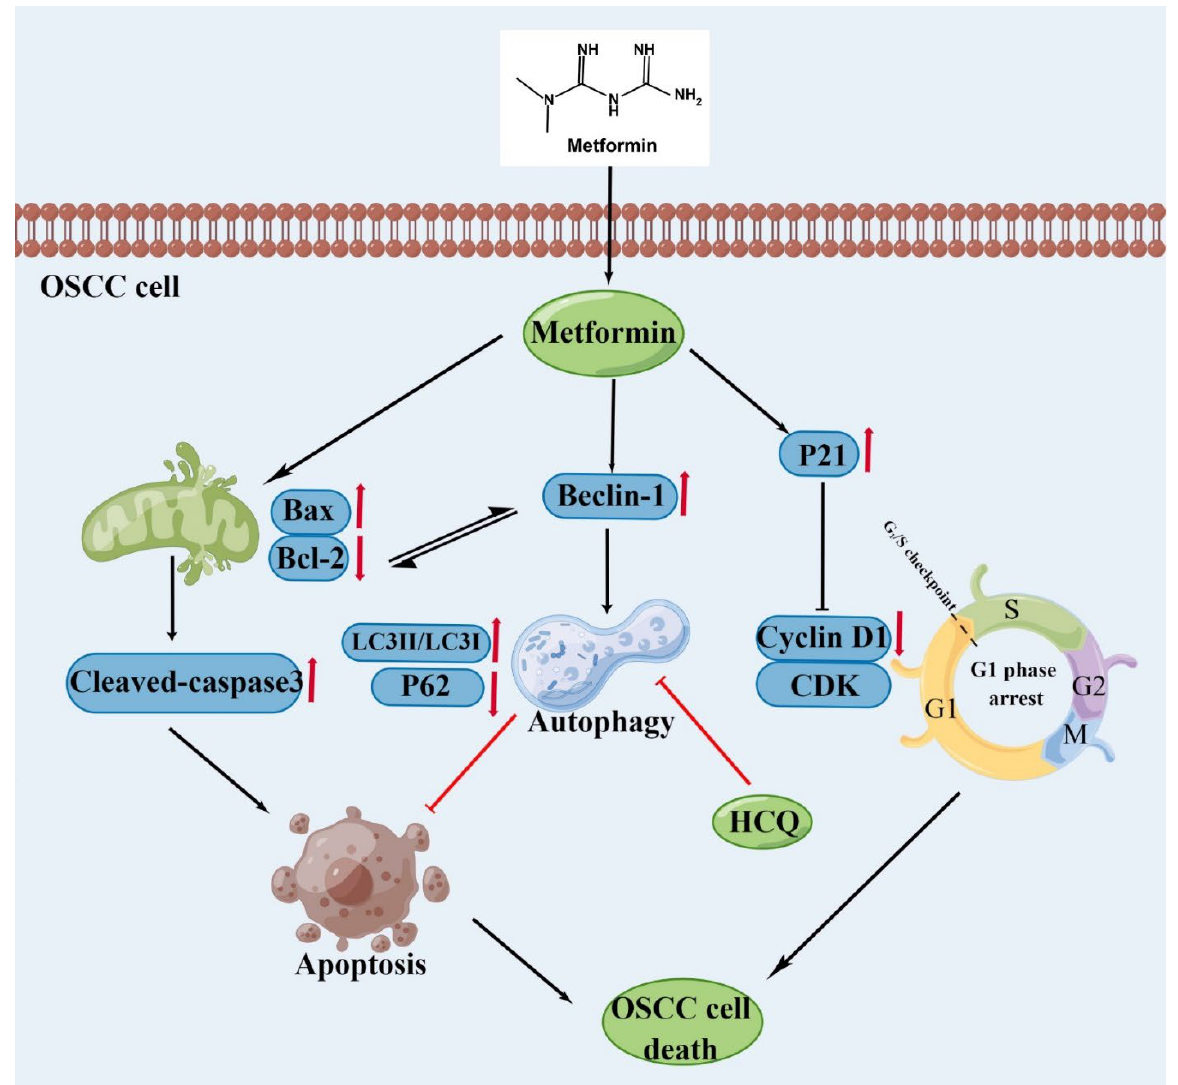
Figure 8. Biochemical pathways involved in the effects of metformin treatment on Oral Squamous Cell Carcinoma (OSCC) cells. Metformin suppresses the proliferation of OSCC cells via the induction of cell cycle arrest and apoptosis. Inhibition of metformin-induced autophagy with HCQ increases the apoptosis of OSCC cells. The figure was created by the Figdraw.